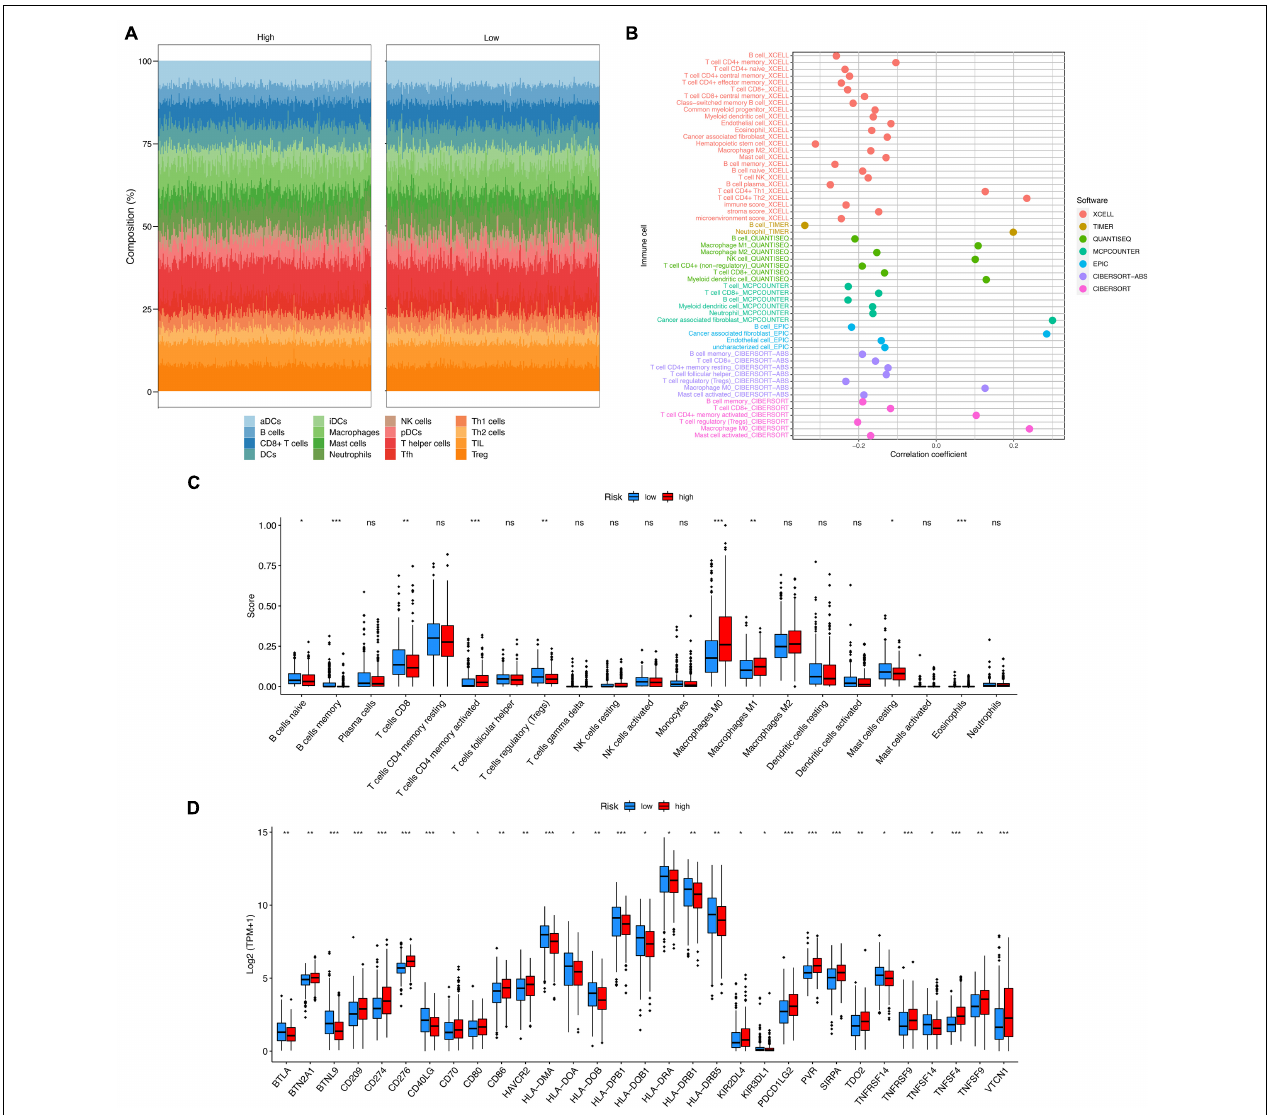
FIGURE 4 | The immunogenomic landscape analyses on the validation set. (A) Compositions of different infiltrated immune cells estimated by ssGSEA. (B) Correlation between risk score and immune cells estimated by XCELL, TIMER, quanTIseq, MCP-counter, EPIC, and CIBERSORT. (C) Boxplot for the immune cell scores in the high- and the low-risk groups, estimated by CIBERSORTx. (D) Boxplot for the expression of an immune checkpoint gene in the high- and the low-risk groups. Adjusted P-values were showed as: ns, not significant; * P < 0.05; ** P < 0.01; *** P <